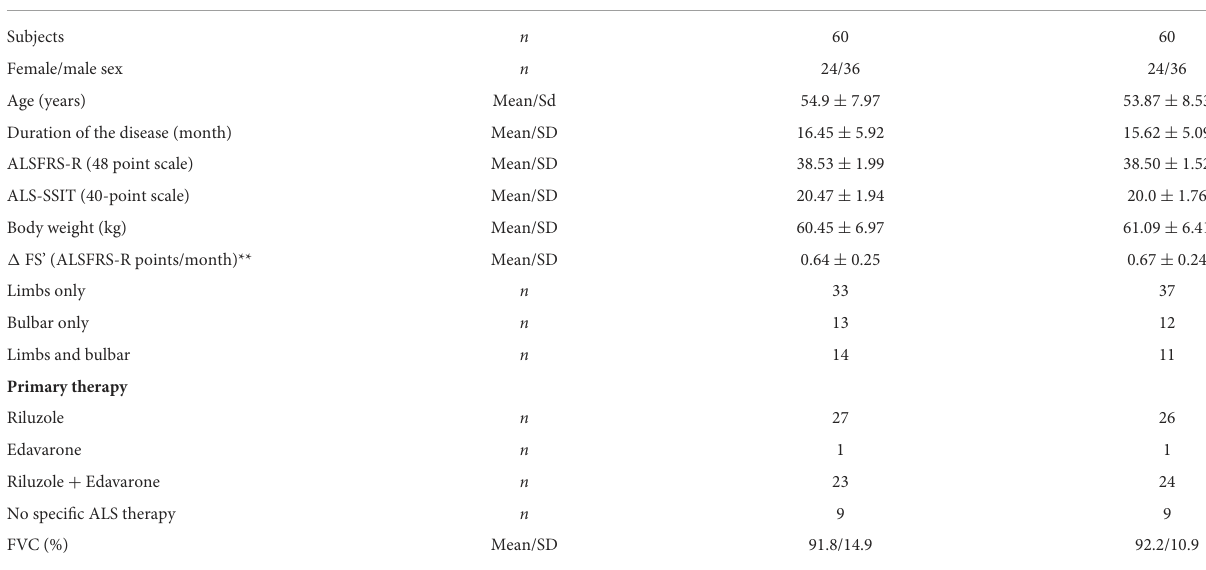
TABLE 2 Characteristics of the JWLP and PLAP